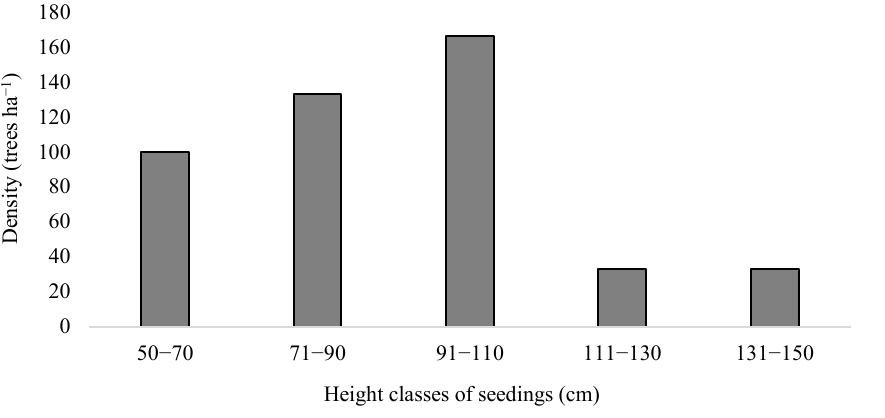
Figure 3. Distribution of height classes of Morus alba seedlings within the Shenxiangou Robinia pseudoacacia plantation. Table 3. Three-factor variance analysis table of light intensity, soil salt content, and maternal tree habitat of Morus alba on seed germination and seedling growth. Gr: germination rate; MGT: